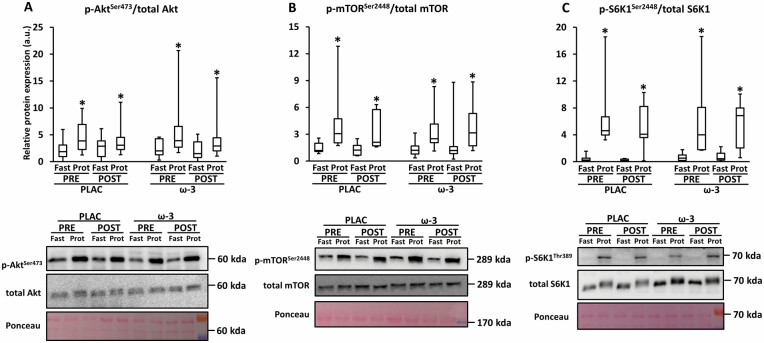
Expression of protein synthesis markers in skeletal muscle tissue in the fasted state (Fast) and after protein bolus (Prot), before (PRE) and after (POST) 12-week resistance exercise in the placebo (PLAC) and omega-3 (ω-3) group. (A) Phosphorylation of Akt at the Ser473-site/total Akt, (B) phosphorylation of mammalian target of rapamycin (mTOR) at the Ser2448-site/total mTOR, (C) phosphorylation of ribosomal S6 kinase 1 (S6K1)/total S6K. For all boxplots, the box represents the interquartile range, the horizontal line in the box represents the median, and the error bars represent the maximum and minimum values. Data were analyzed with a 3-way repeated measures ANOVA to detect differences over time (PRE vs POST), between groups (PLAC vs Ω-3), and state (fasted vs after protein bolus). *p < .05 (POST vs PRE).